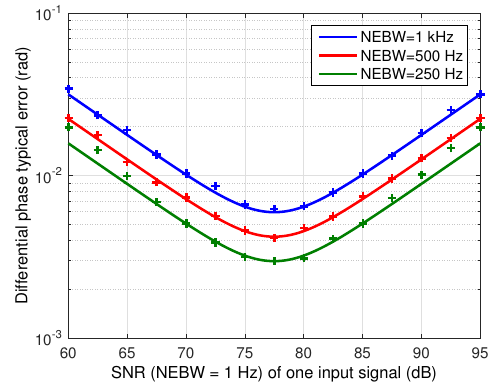
(cid:16) (cid:17) σ ˆ for different noise equivalent bandwidths as a function of SNR φ 12 = [60 dB, 95 dB]) while the other input signal SNR is its A/D = [95 dB, 60 dB]). Theoretical (solid) and simulations A/D